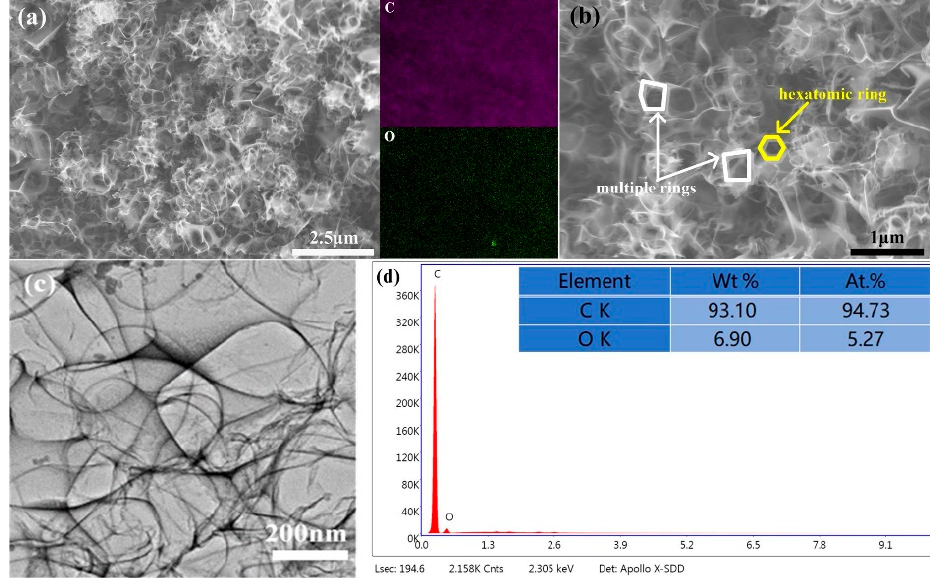
Figure 3. ( a , b ) SEM, ( c ) TEM and ( d ) Elemental surface scan of 3D-CNS.